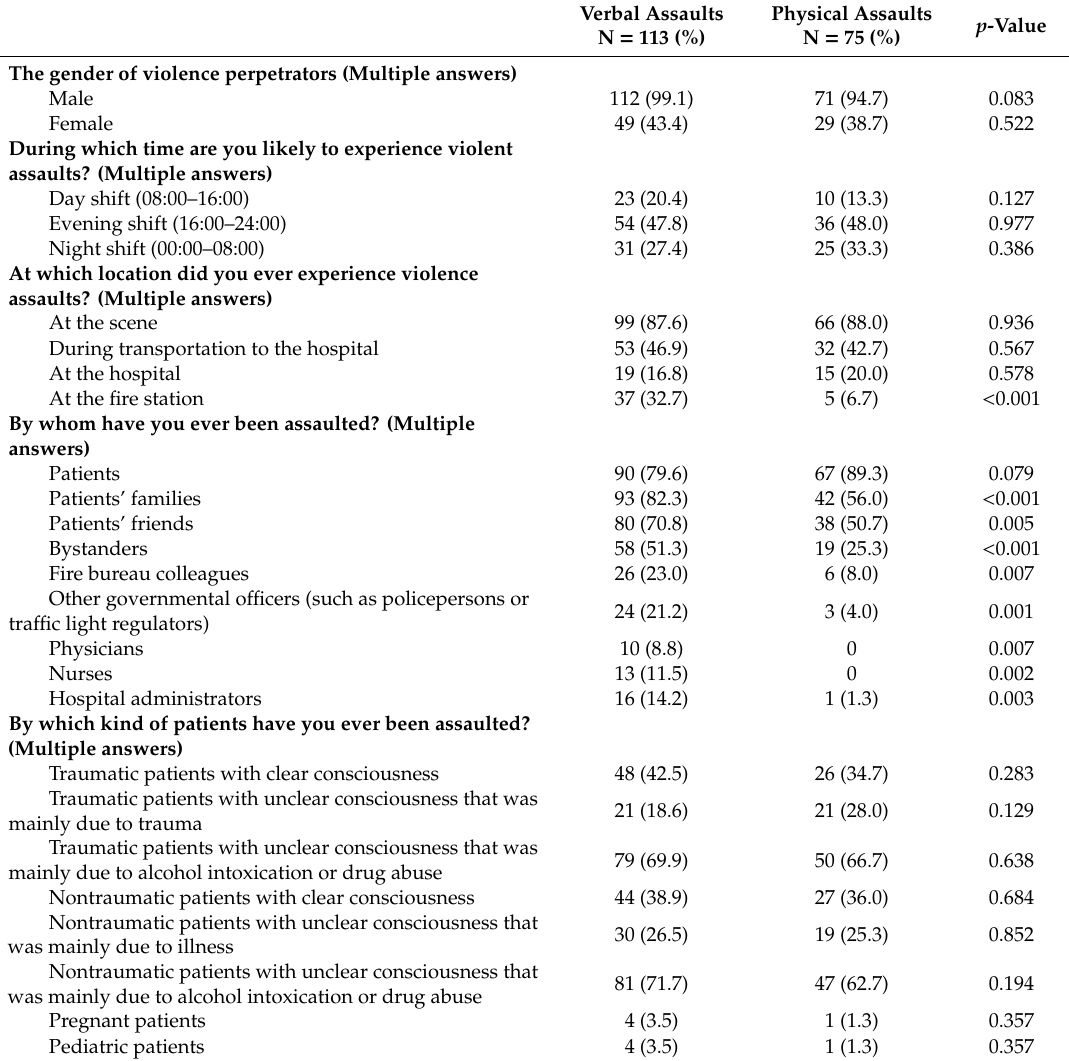
Table 3. Patterns of workplace